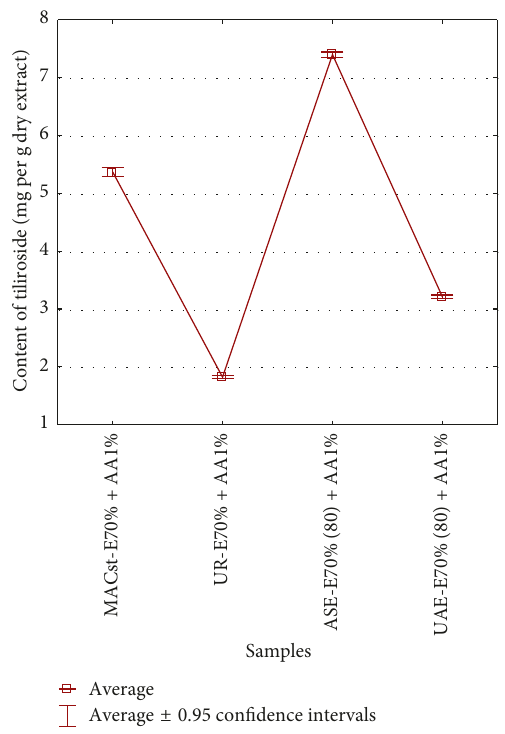
Figure 5: Median graph of the content of tiliroside vs. different extraction